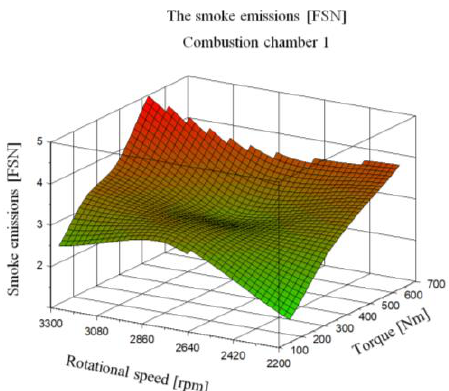
Figure 22. The smoke emission of the engine equipped with the combustion chamber 1.